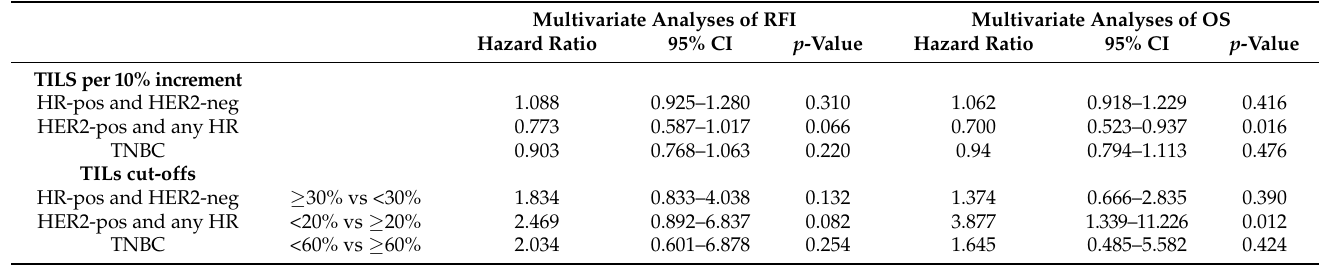
Table 2. Multivariate analyses of TILs considering the recurrence-free interval (RFI) and overall survival